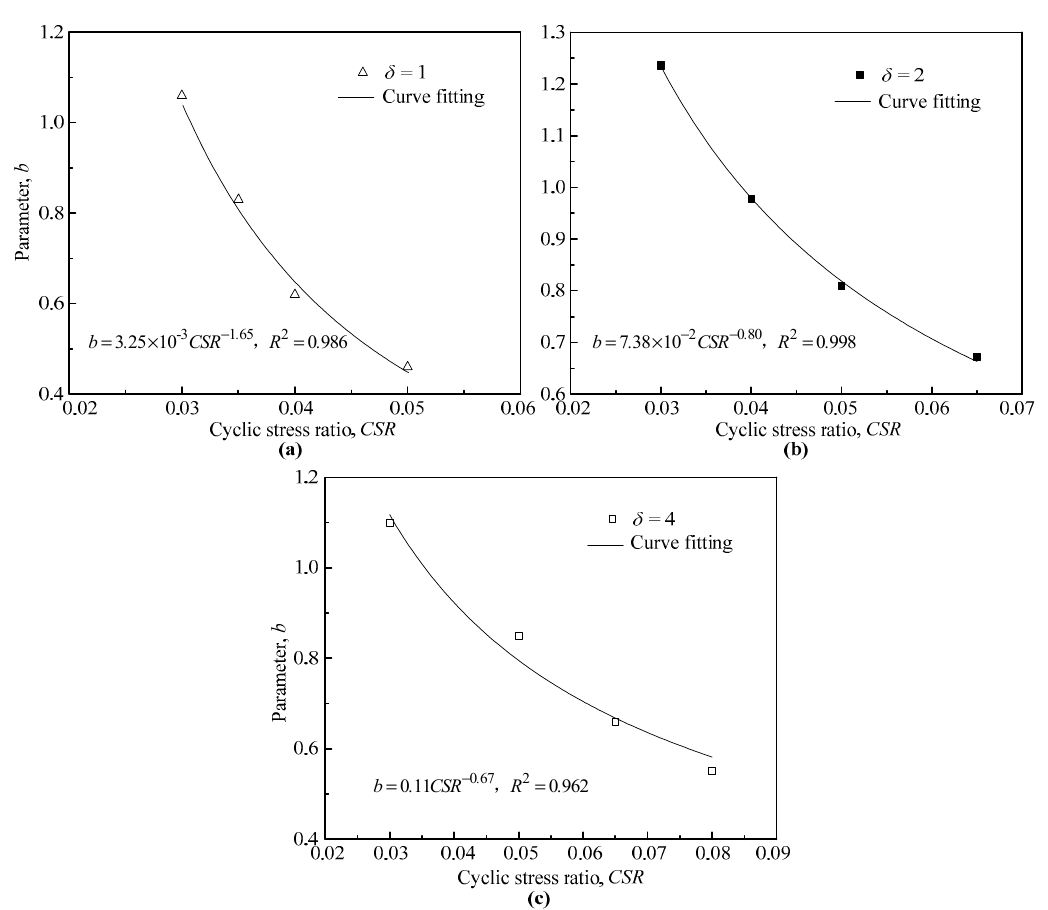
Figure 12. Relationship between parameter b and CSR in Monismith model. ( a ) The relationship between parameter b and CSR when δ = 1; ( b ) The relationship between parameter b and CSR when δ = 2; ( c ) The relationship between parameter b and CSR when δ = 4.